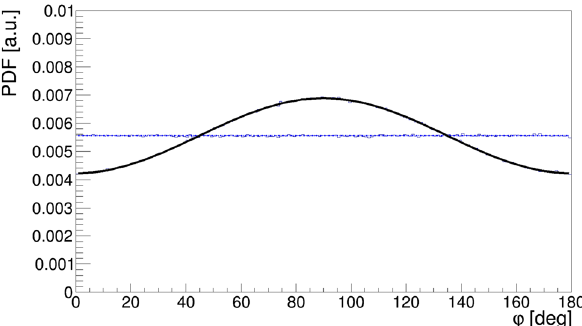
Fig. 9 Distribution of the angle ϕ between scattering planes of the annihilation photons. The black continuous line corresponds to both photons scattered at Compton angle equal to 81 . 66 ◦ , while the blue dashed line to the case where both photons scattered at an angle of 10 ◦ . The simulated histograms are superimposed with the result of the fit of function (7) (for details see text). The simulated histograms and results of the fit are overlapping each other